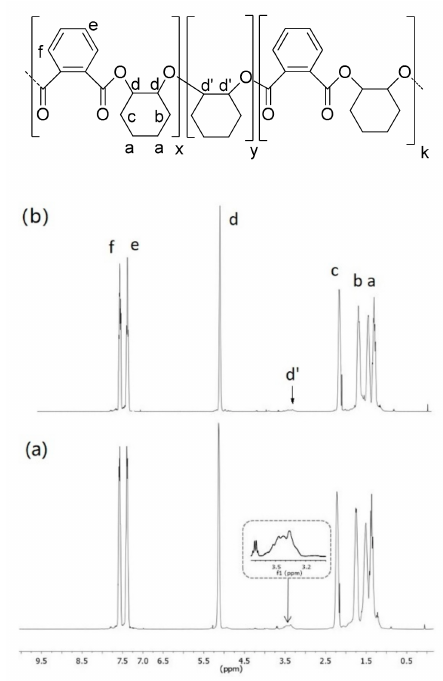
Figure 1. 1 H NMR spectra of poly(CHO- alt -PA) obtained with catalyst 1 and PPNCl as co-catalyst with a pre-contact of 1 h and polymerization time of: ( a ) 24 h (entry CHOPA 18) and ( b ) 1 h (entry CHOPA